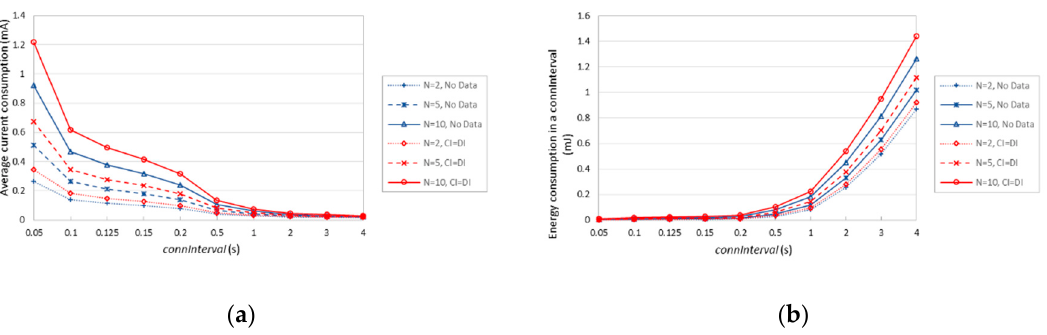
Figure 20. ( a ) Average current consumption of a 6LR, for N = 2, N = 5, and N = 10 connected neighbors. ( b ) Energy consumption of a 6LR in a connInterval , for N = 2, N = 5, and N = 10 connected neighbors.